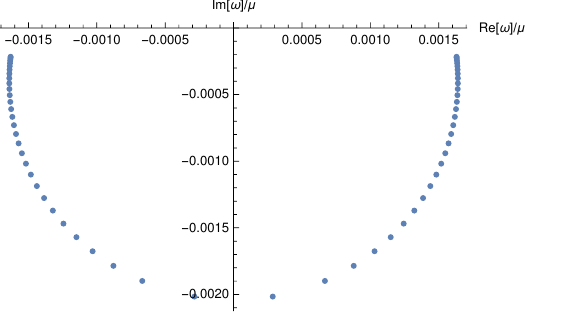
Figure 6 . (cid:21)=(cid:22) = 0 : 0002, k=(cid:22) = 0 : 1, T=(cid:22) = 0 : 1 and 0 : 001 (cid:20) ‘=(cid:22) (cid:20) 0 : 03. As ‘=(cid:22) increases, the complex QNMs move down the lower half plane and approach the imaginary axis, where they eventually